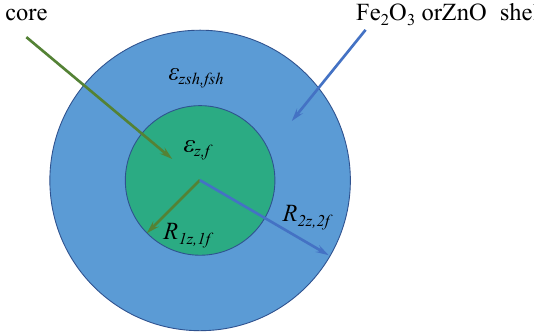
Figure 1. Schematic illustration of the model of core–shell zinc-containing or iron-containing spheri- cal